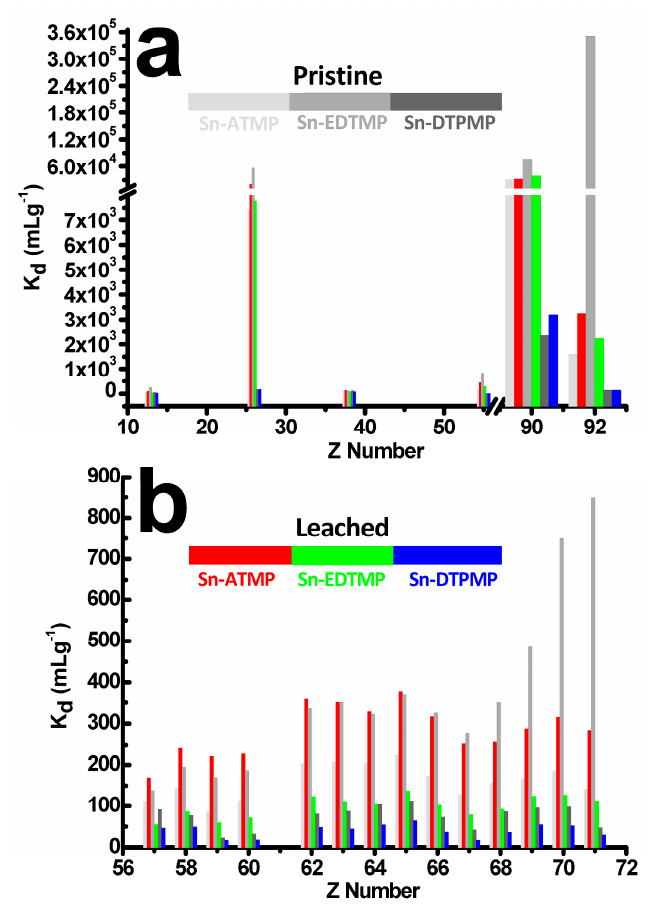
Figure 6. The selective uptake profiles of pristine and leached SnP in radionuclide surrogate bearing 20 elements: ( a ) K d values for alkali, alkaline earth, transitional, light actinides ( b ) detailed K d values for lanthanides.